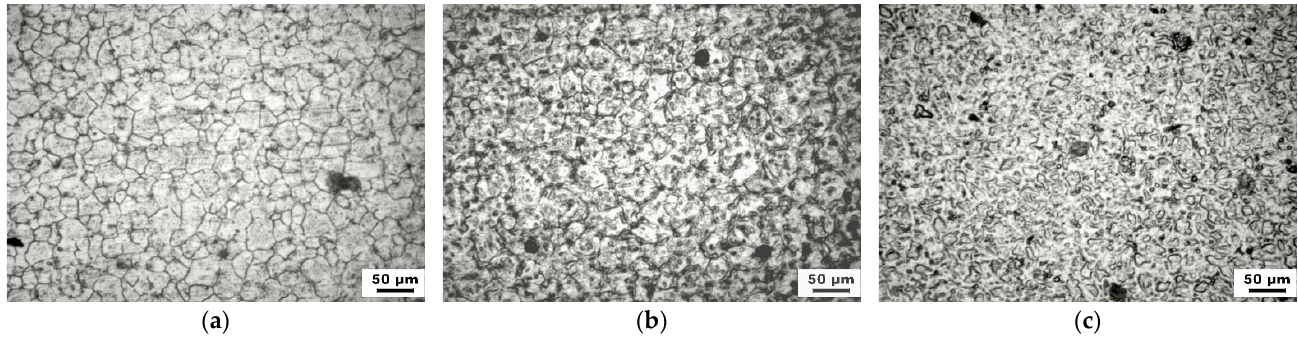
Figure 3. Microstructure of welded joint at activated flux amount of 3 mg/cm 2 . ( a ) Base metal; ( b ) HAZ; ( c ) weld seam.